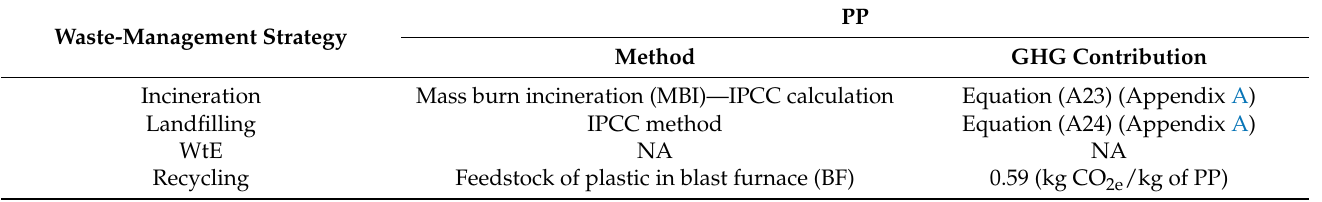
Table 32. PP waste-management technologies used [66,82,83].